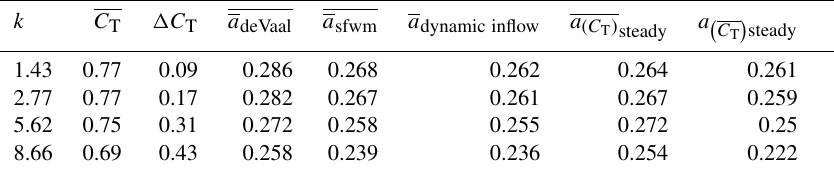
Table 1. Table of averages of the results of Fig. 3. k C T (cid:49)C T a deVaal a sfwm a dynamic